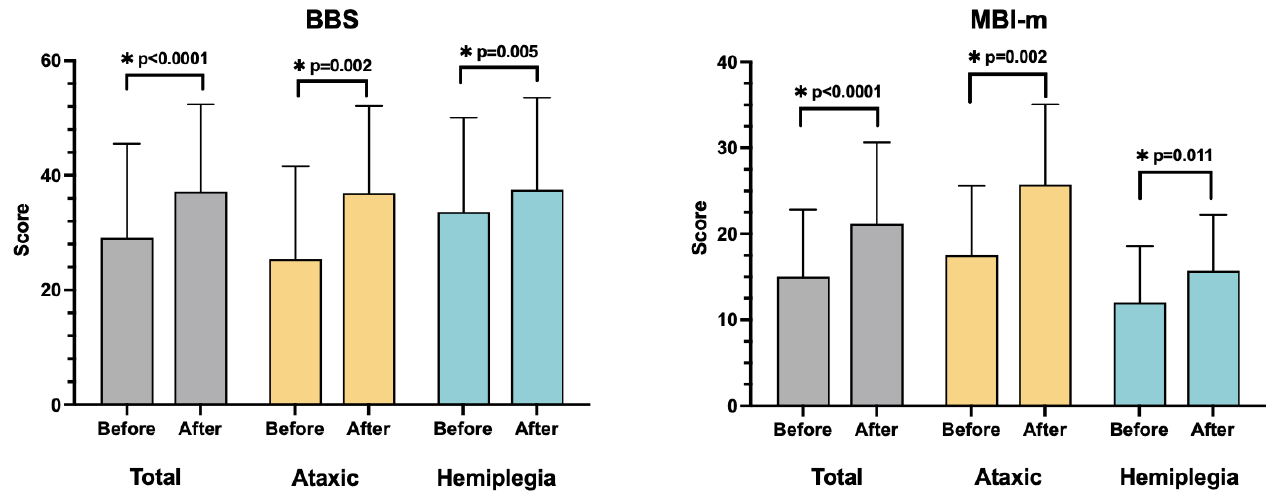
Figure 3. Comparative analysis of the BBS and MBI-m within the groups. All outcome measures improved significantly after RAGT in total subjects and both groups. * p < 0.05, statistically significant. Table 4. Linear regression analysis of the effect of the number of RAGT sessions on BBS and MBI-m. Table 3. Comparative analysis of the FAC within groups. Parameter